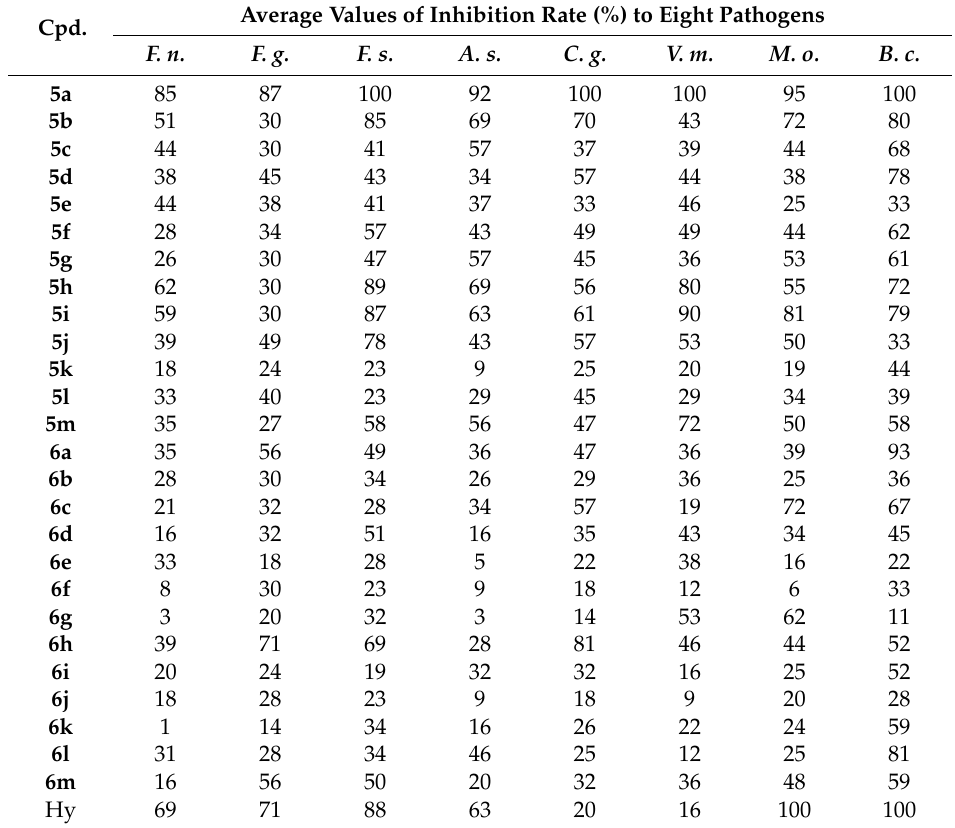
Table 1. Preliminary Antifungal Activities of Compounds at 100 µ g/mL a .